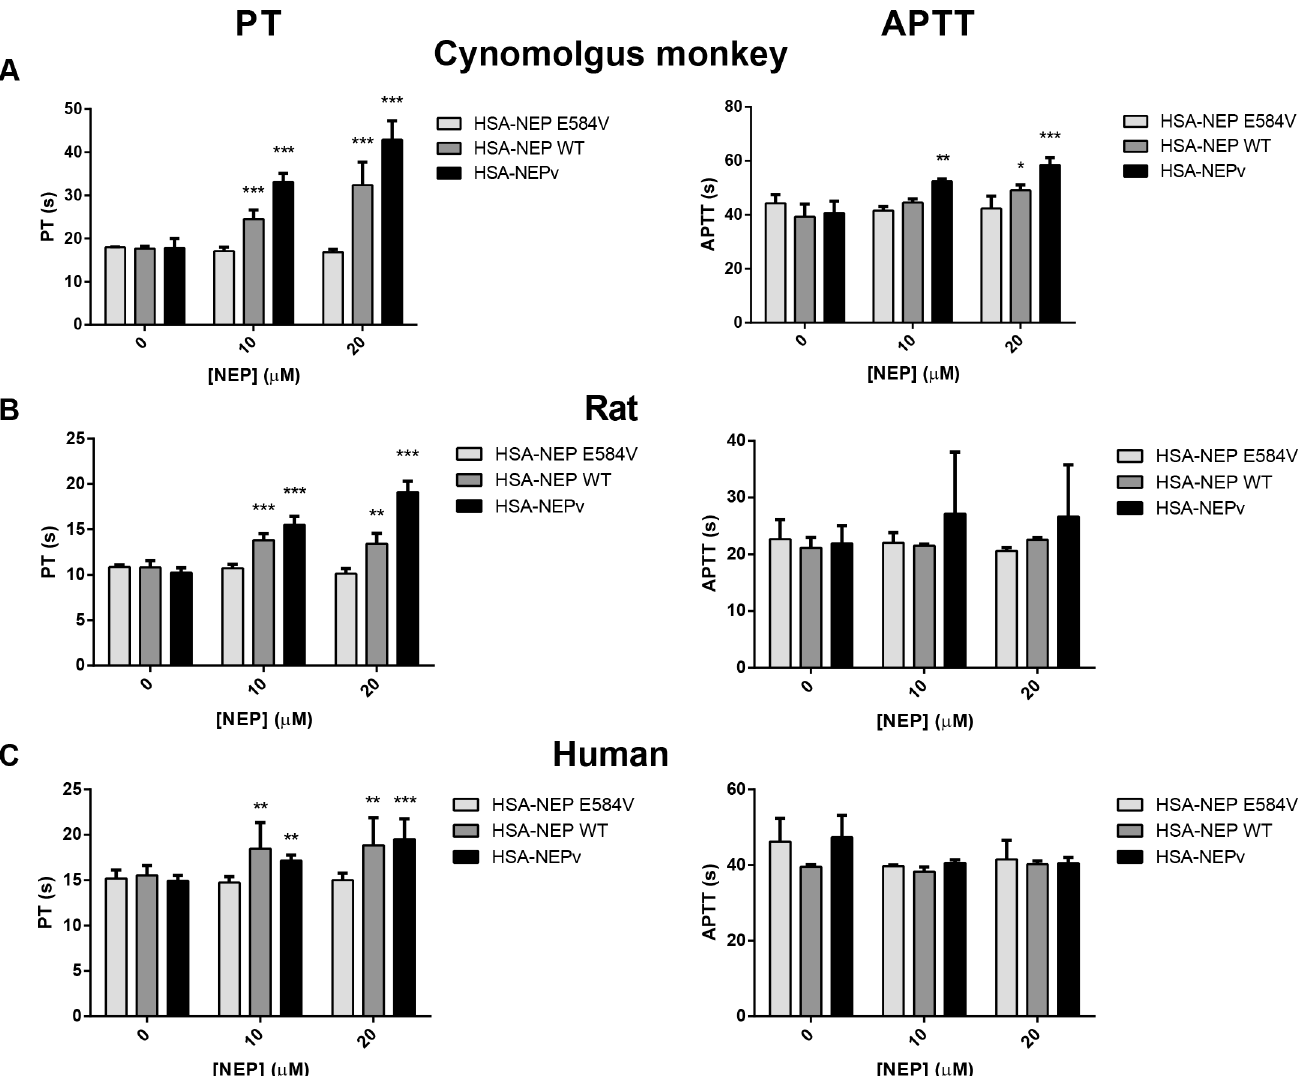
Fig 3. Effect of incubation of NEP in plasma on PT and APTT in vitro . HSA-NEP E584V, HSA-NEP wild type or HSA-NEPv were incubated at 0, 10 or 20 μ M in cynomolgus monkey (A), rat (B) or human plasma (C) for 16 h after which PT (left panel) and APTT (right panel) were measured (mean ± SD; n = 3). Data shown are representative of two replicate